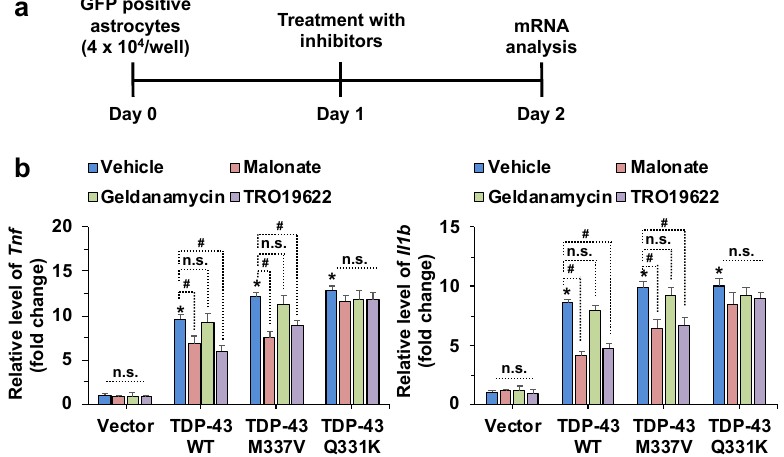
Figure 3. The effects of pharmacological inhibition of SDHA, HSP90AB1, and VDAC3 on the in- flammatory activation of astrocytes induced by TDP-43 transfection. ( a ) Astrocytes were transfected with a GFP , TDP-43 WT , TDP-43 M337V , or TDP-43 Q331K expression construct. After one day, FACS sorting of GFP-transfected cells was performed. ( b ) The relative levels of Tnf and Il1b mRNA in FACS-sorted primary astrocytes were assessed by real-time polymerase chain reaction (RT-PCR). Relative gene expression was normalized to the geometric mean of Gapdh and Actb . * p < 0.05 versus vehicle-treated control vector group; # p < 0.05 versus indicated groups; n.s., not significant. Data analysis by two-way analysis of variance (ANOVA) with four sister wells (biological replicates); mean ± standard deviation (SD).